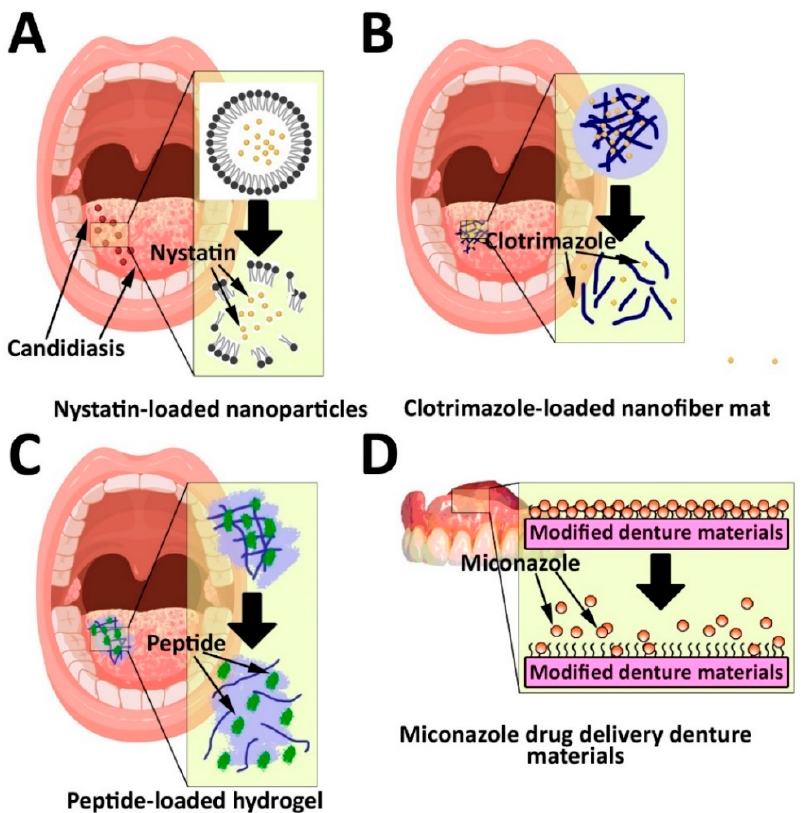
Figure 4. Drug delivery systems for the treatment of oral candidiasis using ( A ) lipid-based nanoparticles, ( B ) nanofiber mat, ( C ) bioadhesive hydrogel, and ( D ) denture materials modified by prolonged miconazole release. The denture materials modified by copolymer improve binding with miconazole, resulting in prolonged drug release.